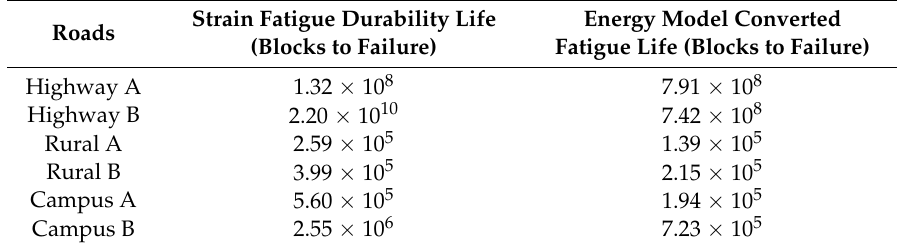
Table 4. Predicted Morrow fatigue lives using measured and elastic-energy model converted strain.